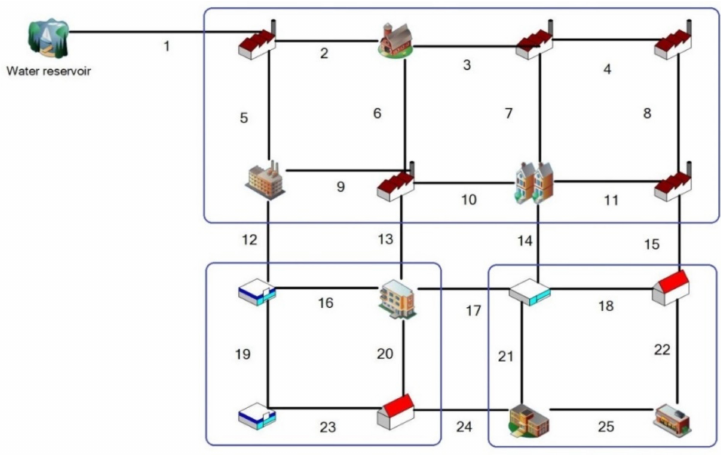
Figure 1. An illustrative example of a WDS with three pressure